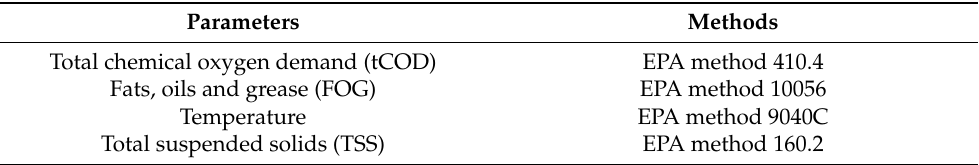
Table 2. Analytical methods used for measuring of the samples.